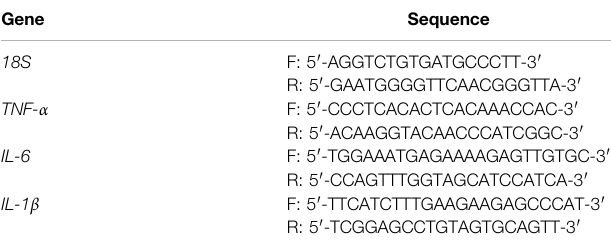
TABLE 1 | Primer sequence for quantitative real-time